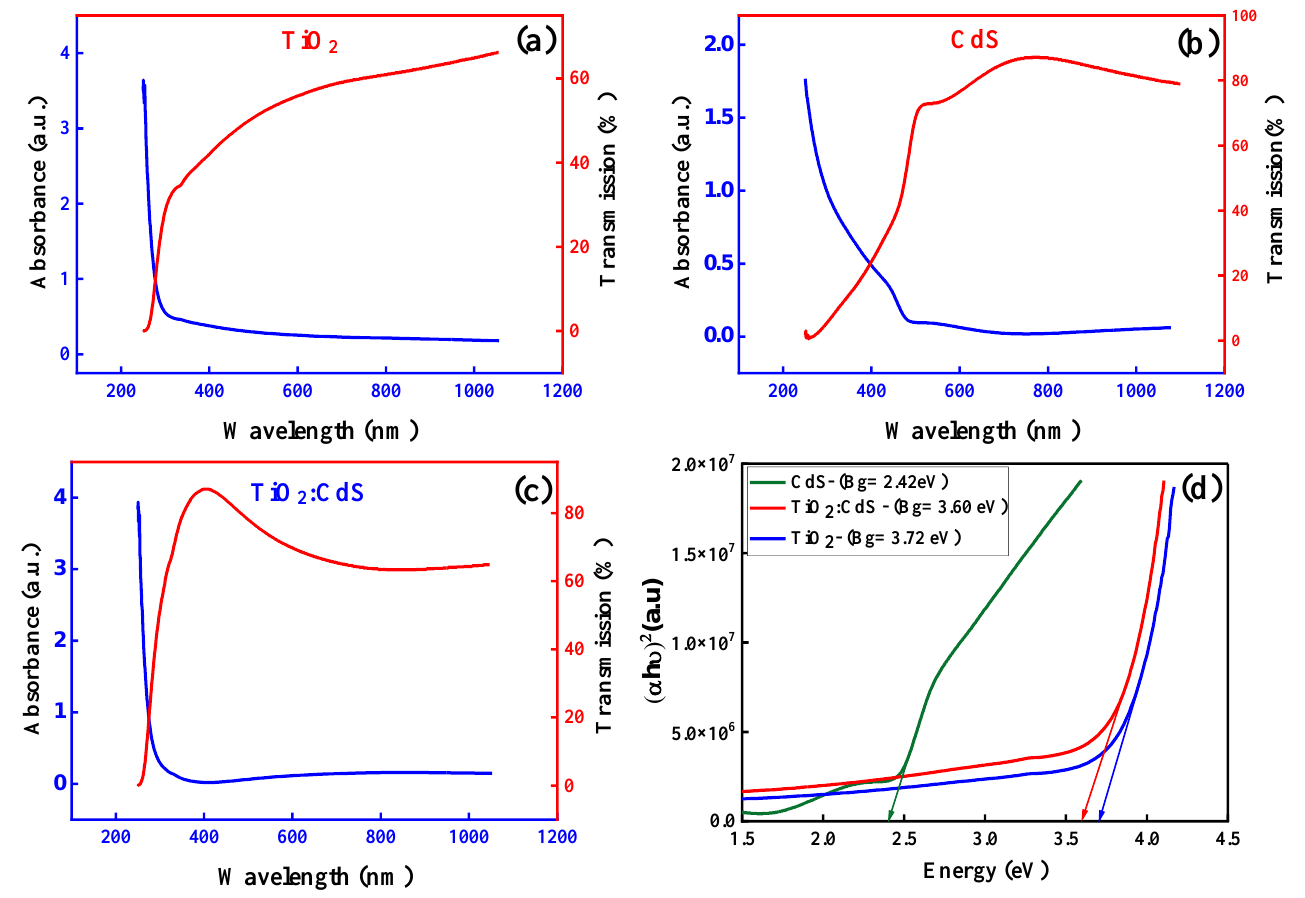
Figure 4. ( a ) Absorbance and transmission spectra of TiO 2 , ( b ) absorbance and transmission spectra of CdS, ( c ) absorbance and transmission spectra of TiO 2 :CdS, and ( d ) Tauc plot (band gap) of prepared samples.